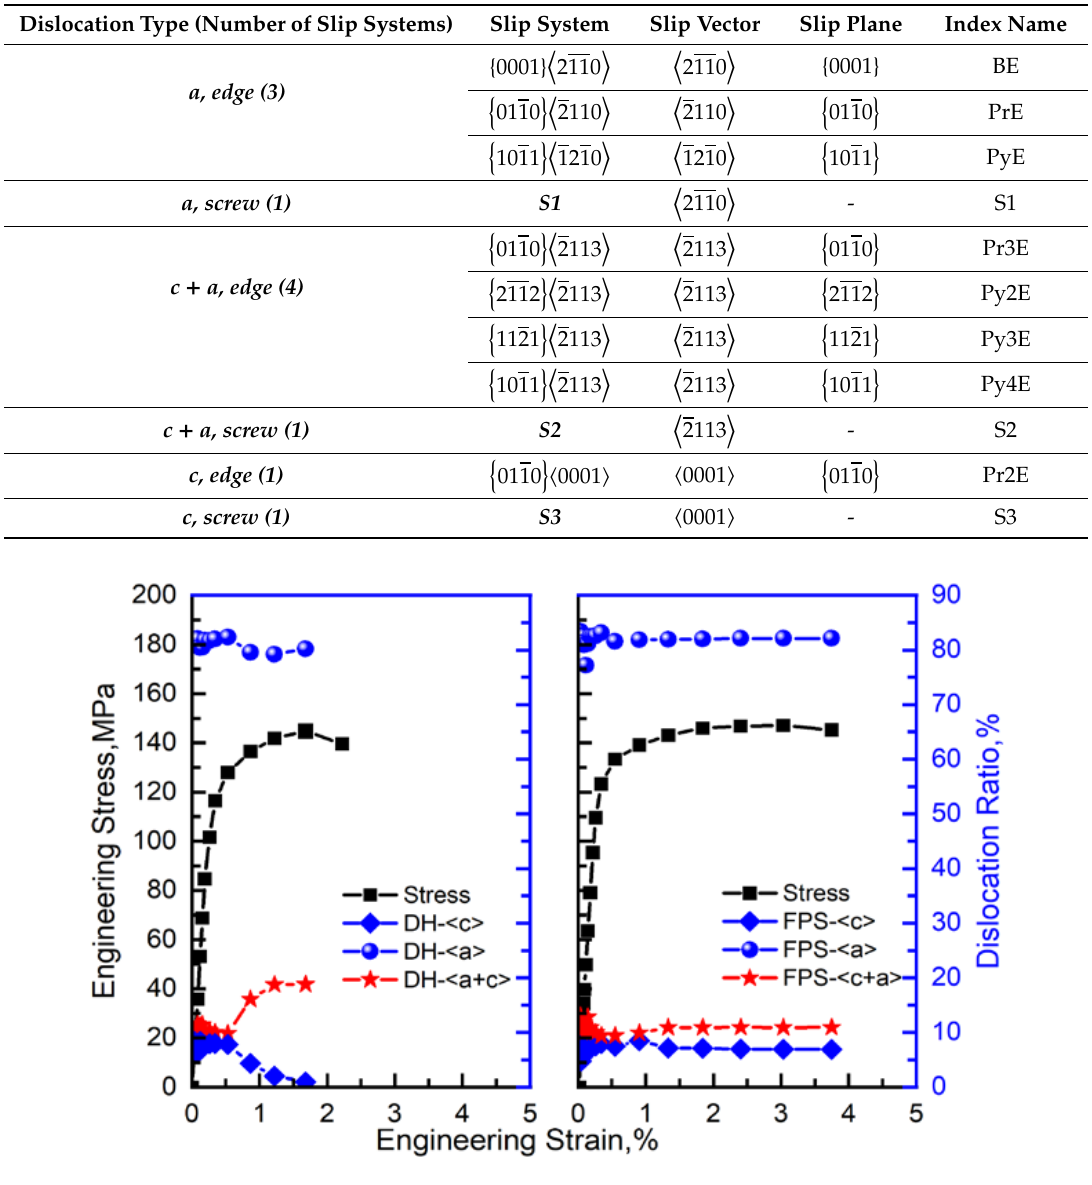
Table 1. The most common slip systems in the hexagonal crystal structure [5,8]. Dislocation Type (Number of Slip Systems)